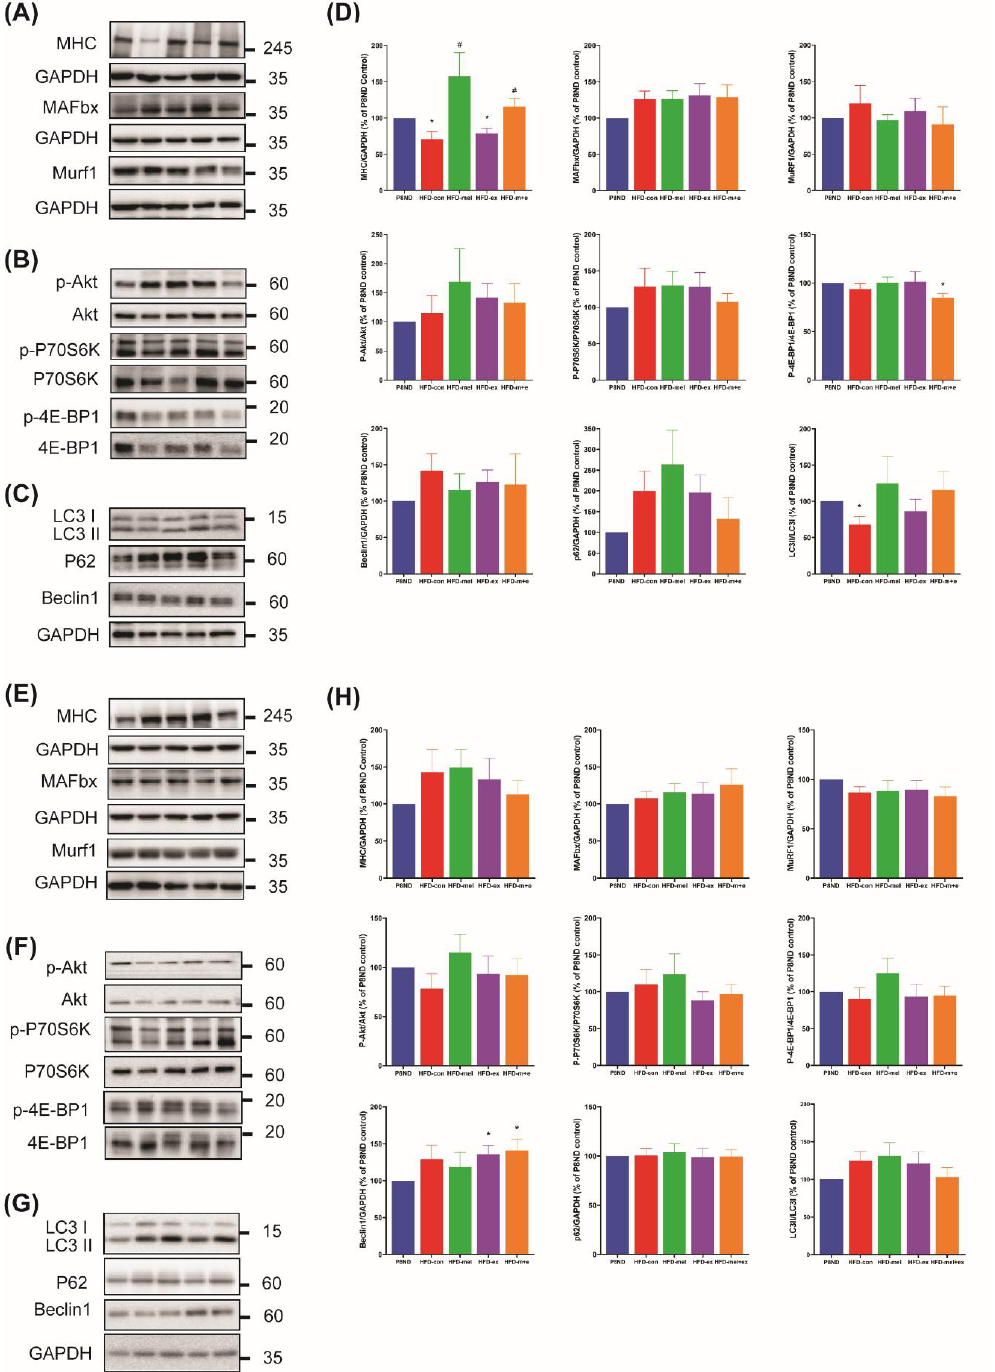
Figure 3. Effects of melatonin and exercise training on protein expression contributing to the molec- ular mechanisms associated with sarcopenia in the ( A – D ) soleus muscle and ( E – H ) white gas- trocnemius muscle. Representative immunoblots of ( A , E ) MHC, MAFbx, and MuRF1, ( B , F ) the P-Akt/P-P70S6K/P-4EBP1 pathway, and ( C , G ) Beclin1/LC3I/II/P62 protein expression in the soleus muscle and white gastrocnemius muscle, respectively. ( D , H ) Graphs illustrate the densitometric analysis of protein levels, which were normalized to GAPDH or total form. Data are the mean ± SD (n = 6 – 10 mice per group); * p < 0.05 vs. P8ND by one-sample t -test, and # p < 0.05 vs. HFD-con by unpaired t